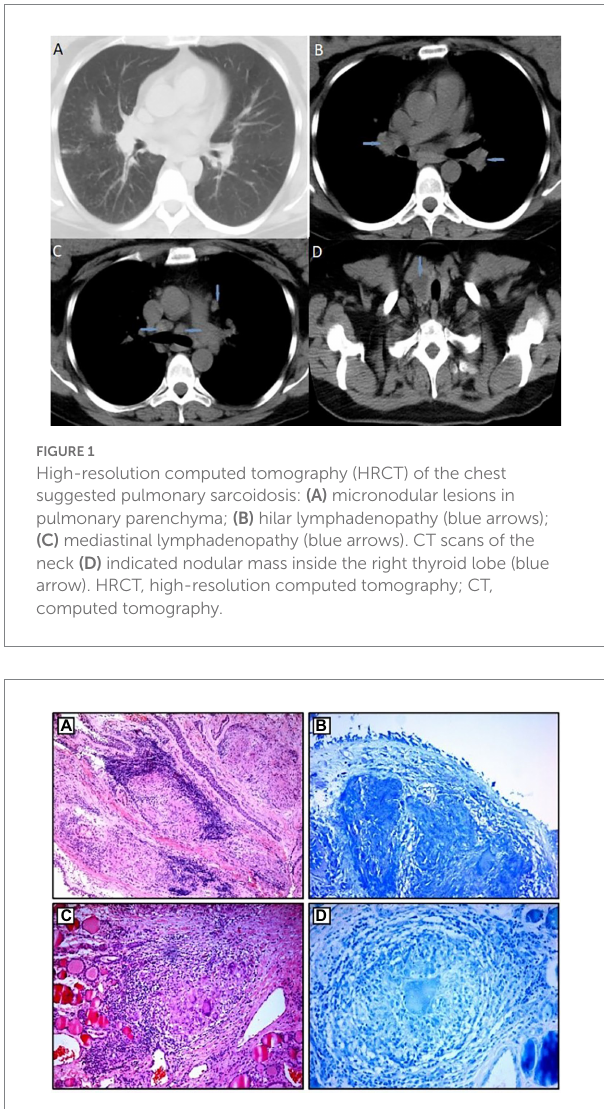
FIGURE 2 Histopathological examination: (A,B) non-necrotizing granulomas in bronchial mucosa and acid-fast stain showing absence of AFB; (C,D) thyroid tissue with non-necrotizing granulomas and acid-fast stain showing the absence of AFB. AFB, acid-fast